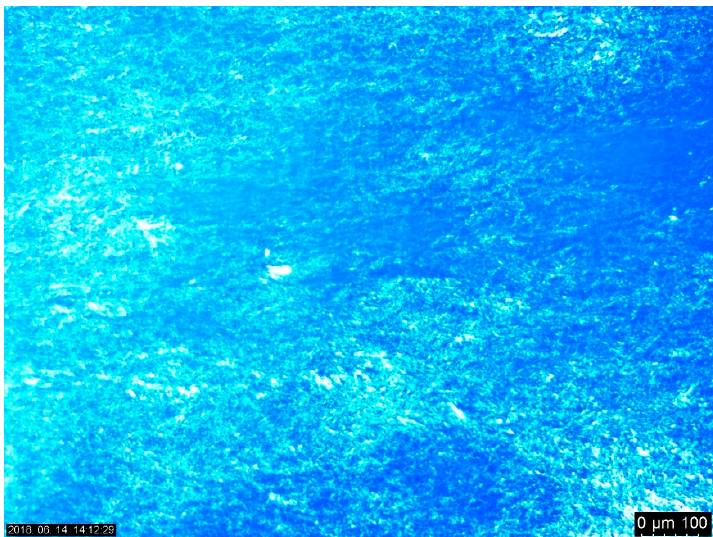
Figure 2. The solid lipid particles (LID-NLC) gel in polarized light at week two. (The magnification was 100×).